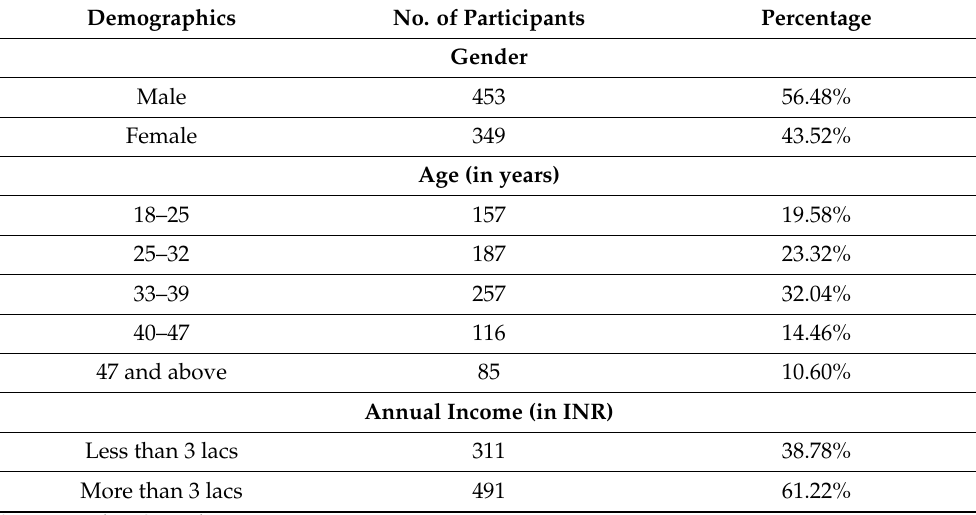
Table 1. Descriptive